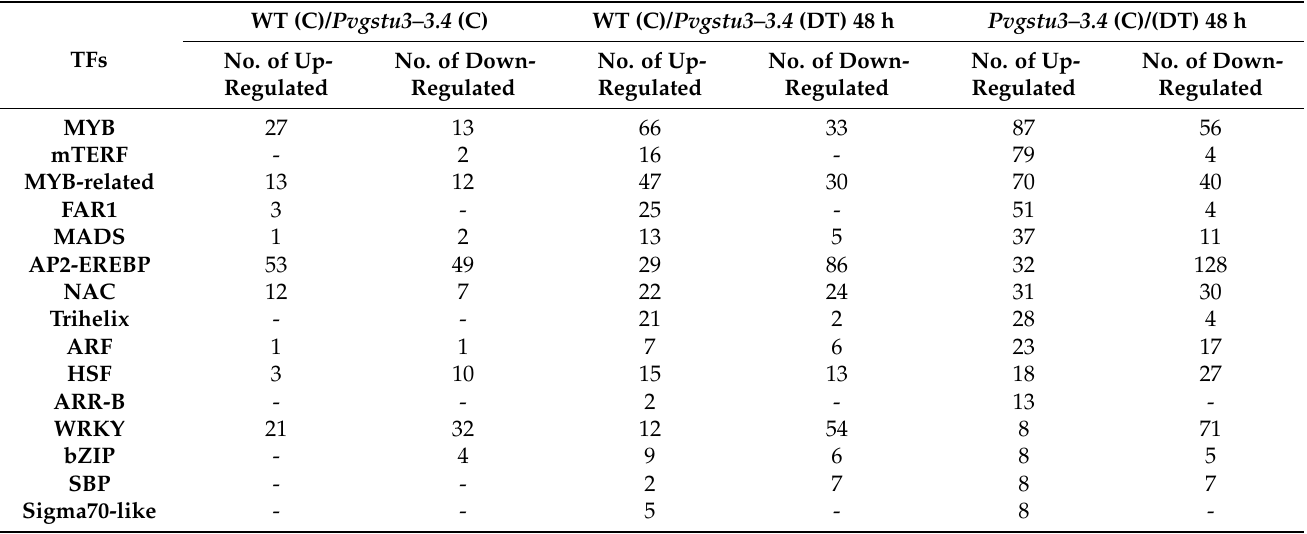
Table 4. Top 15 representative transcription factors (TFs) and the number of up- and downregulated genes in response to stress-free (C) conditions and combined drought and heat stress (DT) at 48 h in WT and Pvgstu3–3.4 transgenic plants.